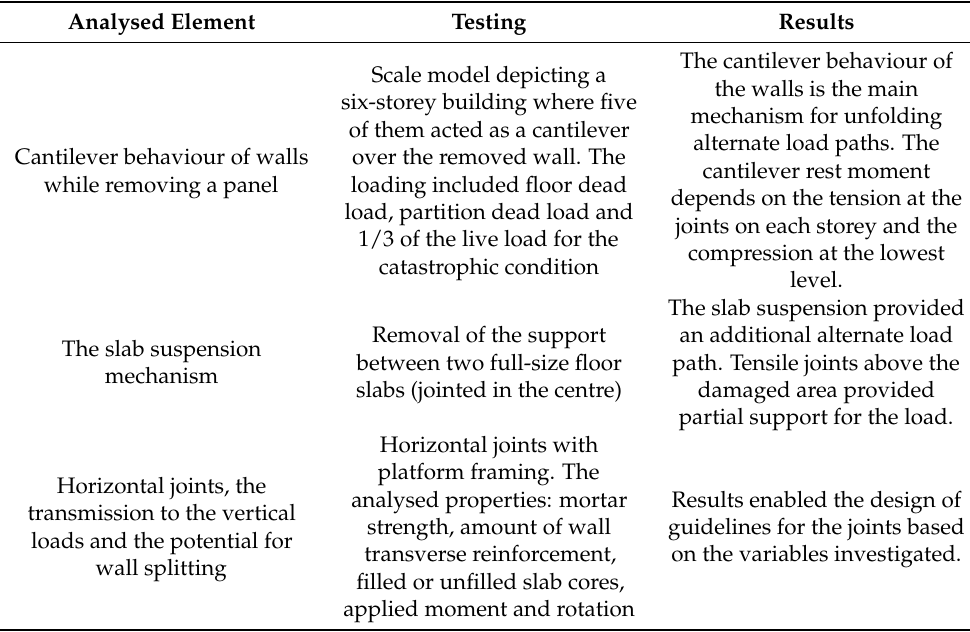
Table 2. Results of tests by the Portland Cement Association (based on the information provided in [59–63]).